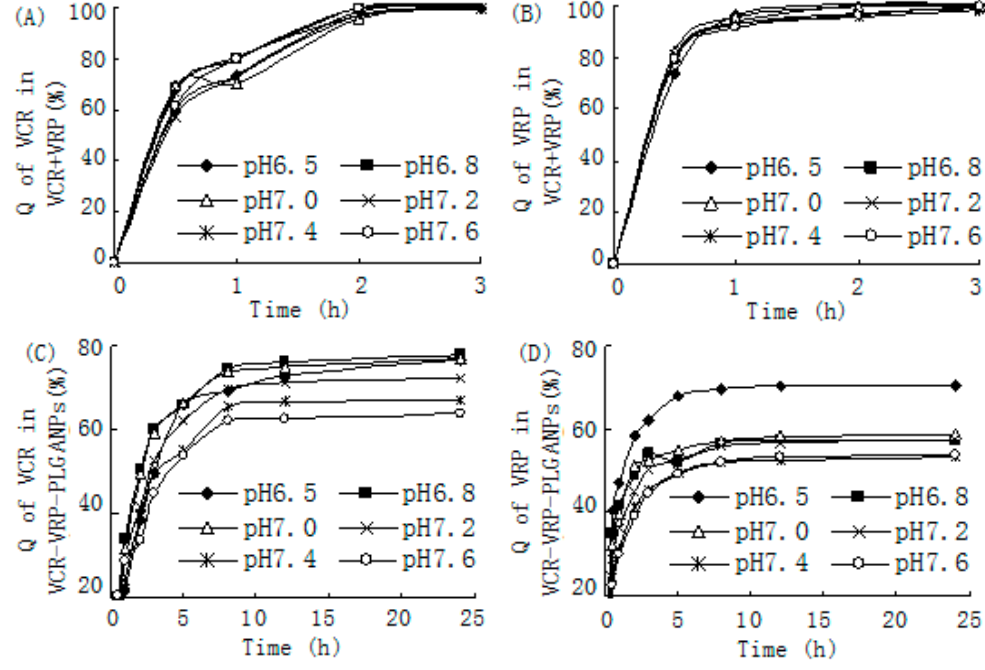
with various pH values. ( A ) The accumulative release quantity (Q) of VCR from free VCR/VRP combinations within 3 h; ( B ) The accumulative release quantity (Q) of VRP from free VCR/VRP combinations within 3 h; ( C ) The accumulative release quantity (Q) of VCR from VCR-VRP-PLGANPs within 24 h; ( D ) The accumulative release quantity (Q) of VRP from VCR-VRP-PLGANPs within 24 h.